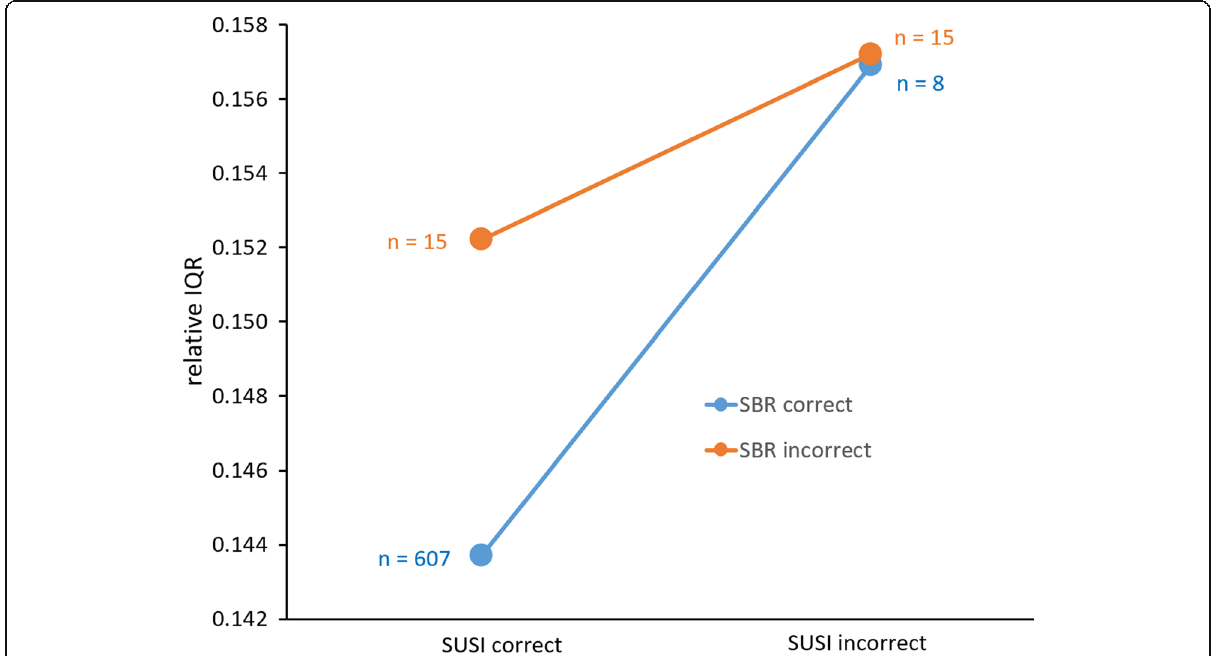
Fig. 5 Interquartile range (IQR) relative to the 75th percentile of the voxel intensity in the reference region according to correctness of SUSI- based and SBR-based classification of the PPMI FP-CIT images as PD or HC ( “ correct ” = true positive or true negative, “ incorrect ” = false positive or false negative). The relative IQR is as measure of the uncertainty of the estimate of the non-displaceable count density by the 75th percentile of the voxel intensity in the reference SUSI versus SBR in harmonized multi-site versus mono- camera setting